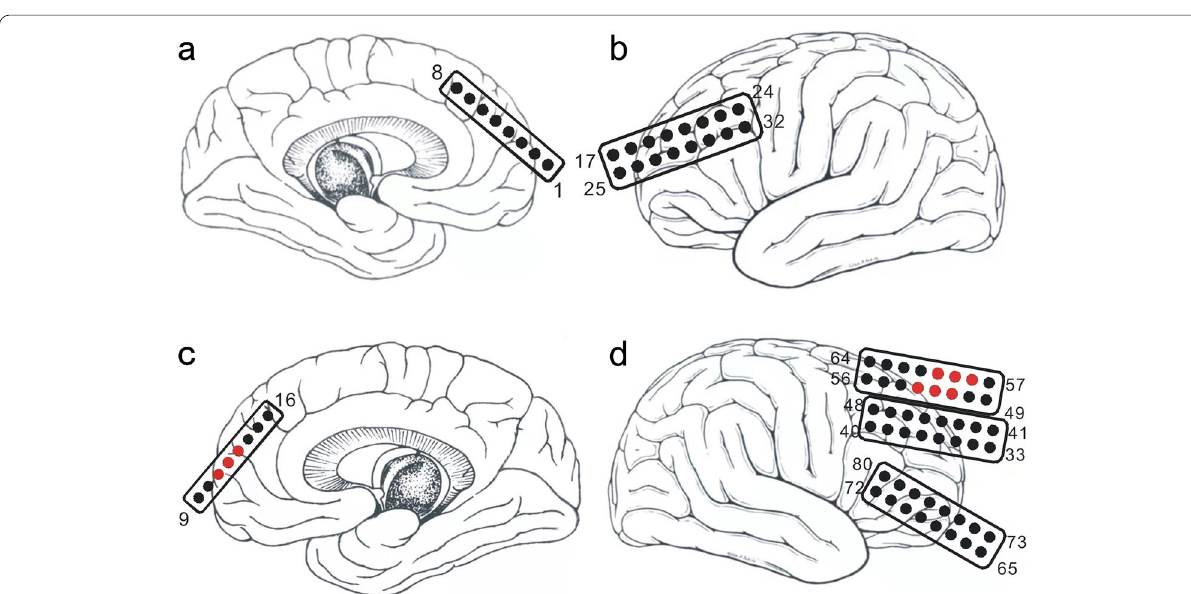
Fig. 2 Diagram of electrode locations in patient 1 (Red dots indicate seizure onset areas according to